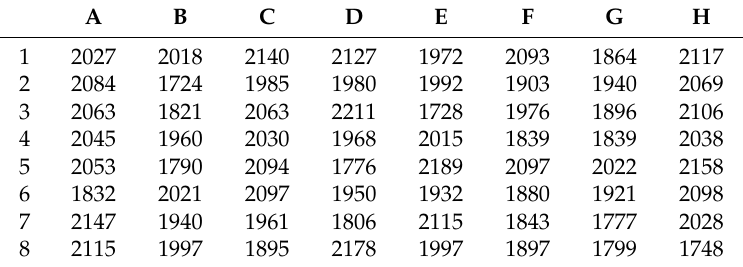
Table A9. Pressure loss in Experiment A3 (Pa). Item Measurement Value Total pressure loss 640 Pressure loss (catalysts excluded) 250